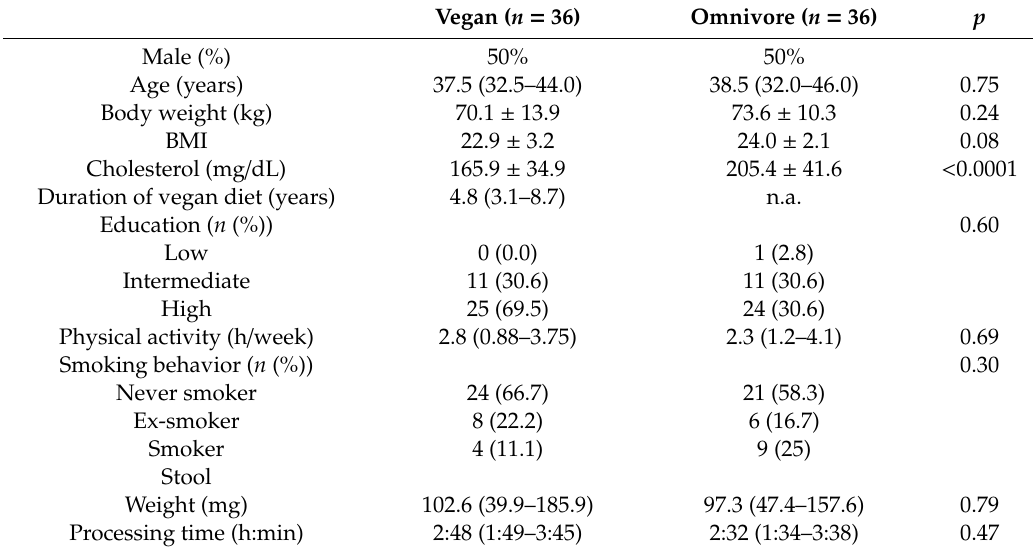
Table 1. Characteristics of the Risk and Benefits of a Vegan Diet study (RBVD)